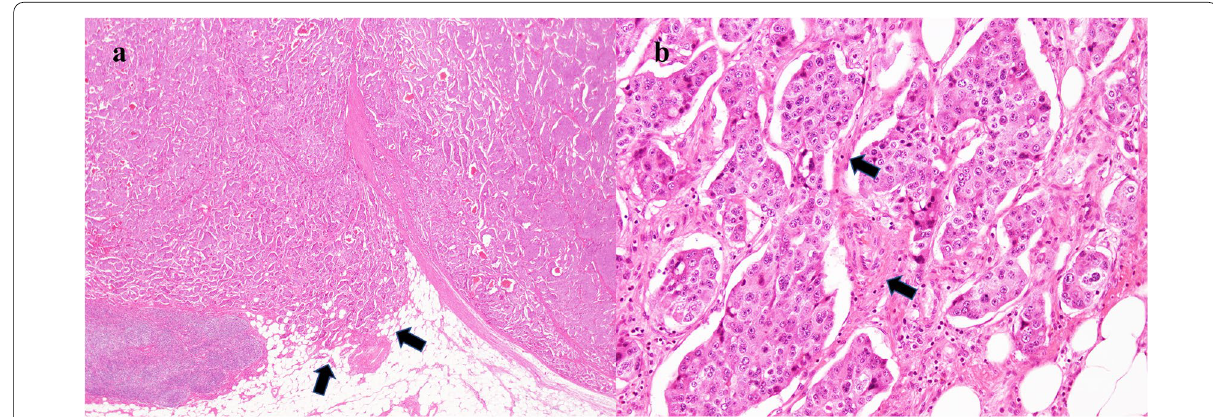
Fig. 5 Histopathological findings (H&E). a ( 40) Proliferative infiltration of atypical cells of unequal size and irregular spore structure. Some of them × infiltrate the surrounding adipose tissue (arrows). b ( 200) Proliferating atypical cells have round nuclei and relatively abundant cytoplasm with × pale eosinophilia. There are narrow fibrovascular interstitial spaces between atypical cell foci